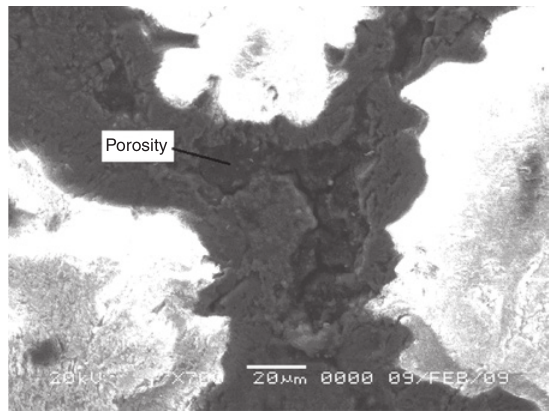
Figure 6: SEM micrograph of the composite with a reinforcement size of 149 μ